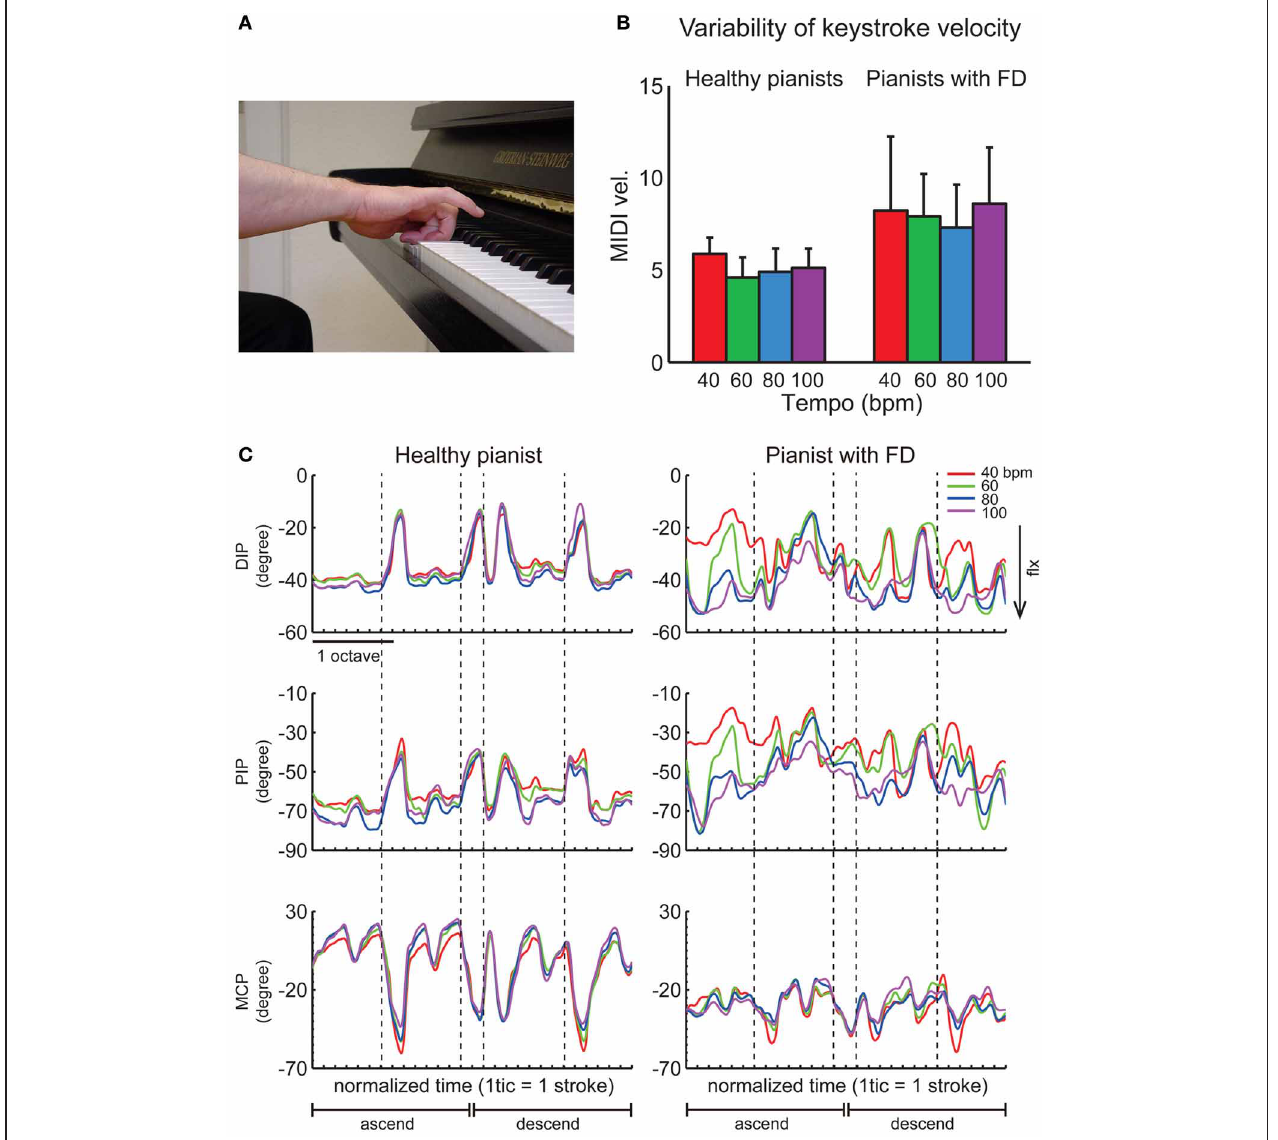
pianist (left panel) and a pianist having the ring finger affected (right panel) during playing a two-octave C-major scale in both ascending and descending directions at four different tempi (different colors). Each tick indicates the moment of each keystroke, and each vertical dotted line indicates the moment of a stroke with the ring finger. The negative value defines joint flexion. The joint angle was measured by a custom-made data glove (Gentner and Classen, 2009). (B,C) are derived from Furuya and Altenmüller